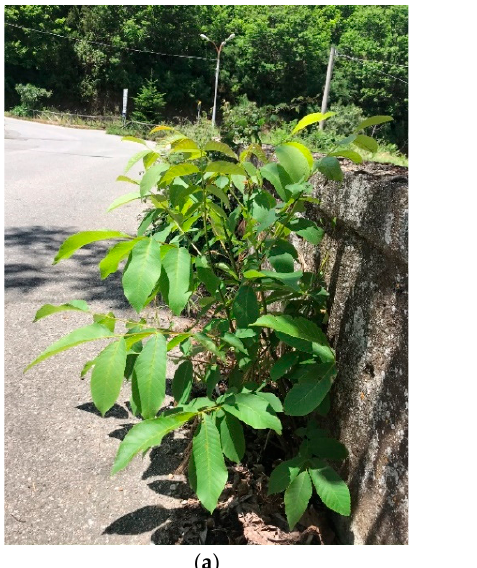
Figure A6. Ipomoea setosa Ker-Gawl. subsp. pavonii (Hallier f.) J.R.I. Wood & Scotland found for the first time in Europe in Rizziconi (Reggio Calabria province). ( a ) Flower in front view; ( b ) flower in side view; ( c ) stem and leaves; ( d ) hairy seeds; ( e ) location of the new record; ( f ) particular of the low part of the plant born along a rural way (Photographs S Cannavò).